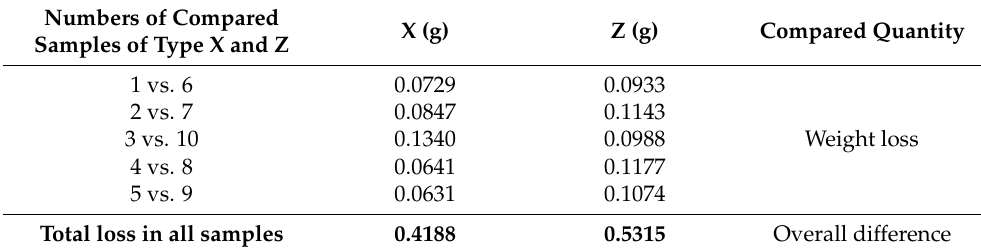
Table 11. Comparison of weight loss in the X- and